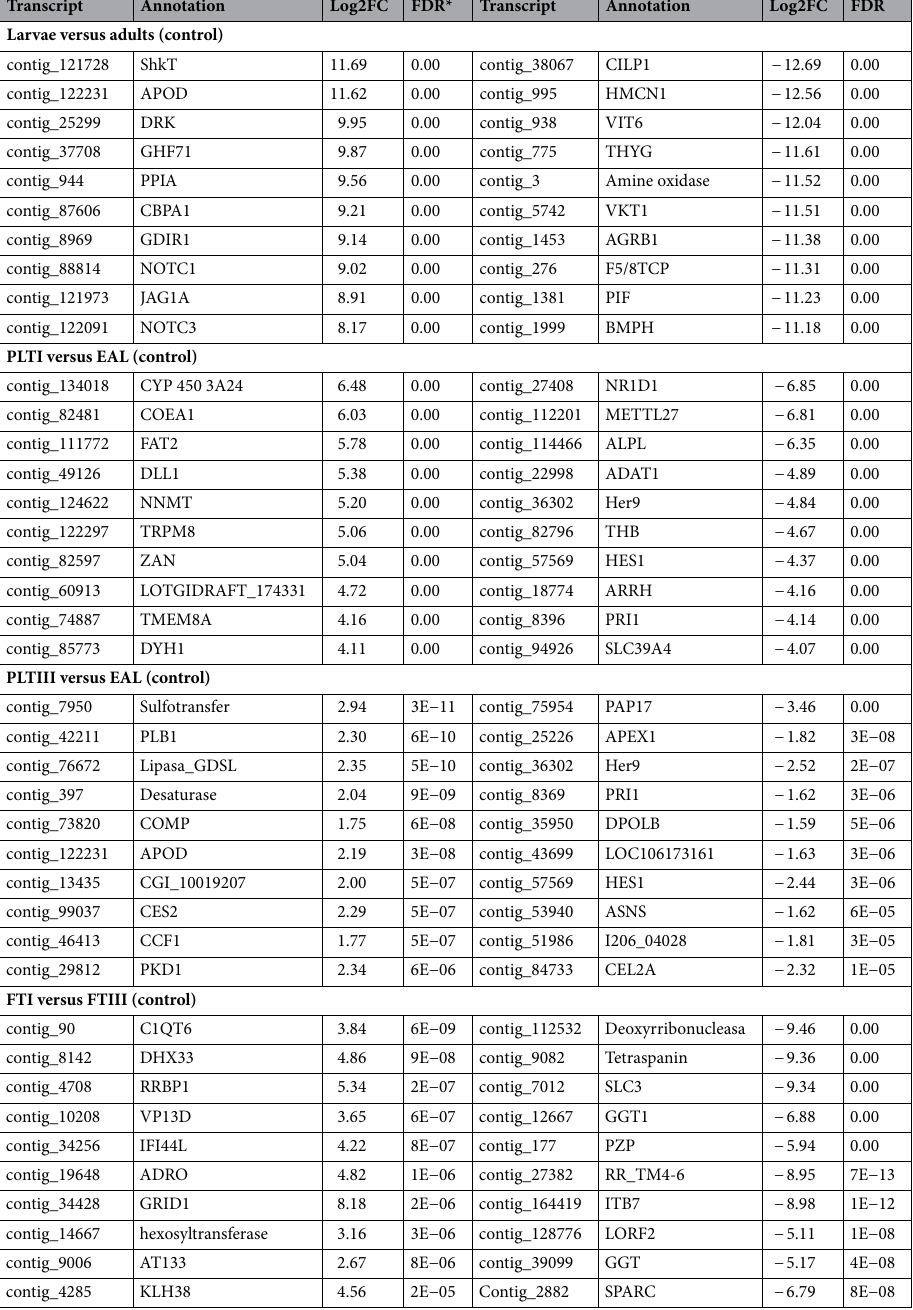
Table 2. The top ten up- and down-regulated genes of differential expression analysis. *FDR = 0.00 indicates values of 1E−16 or